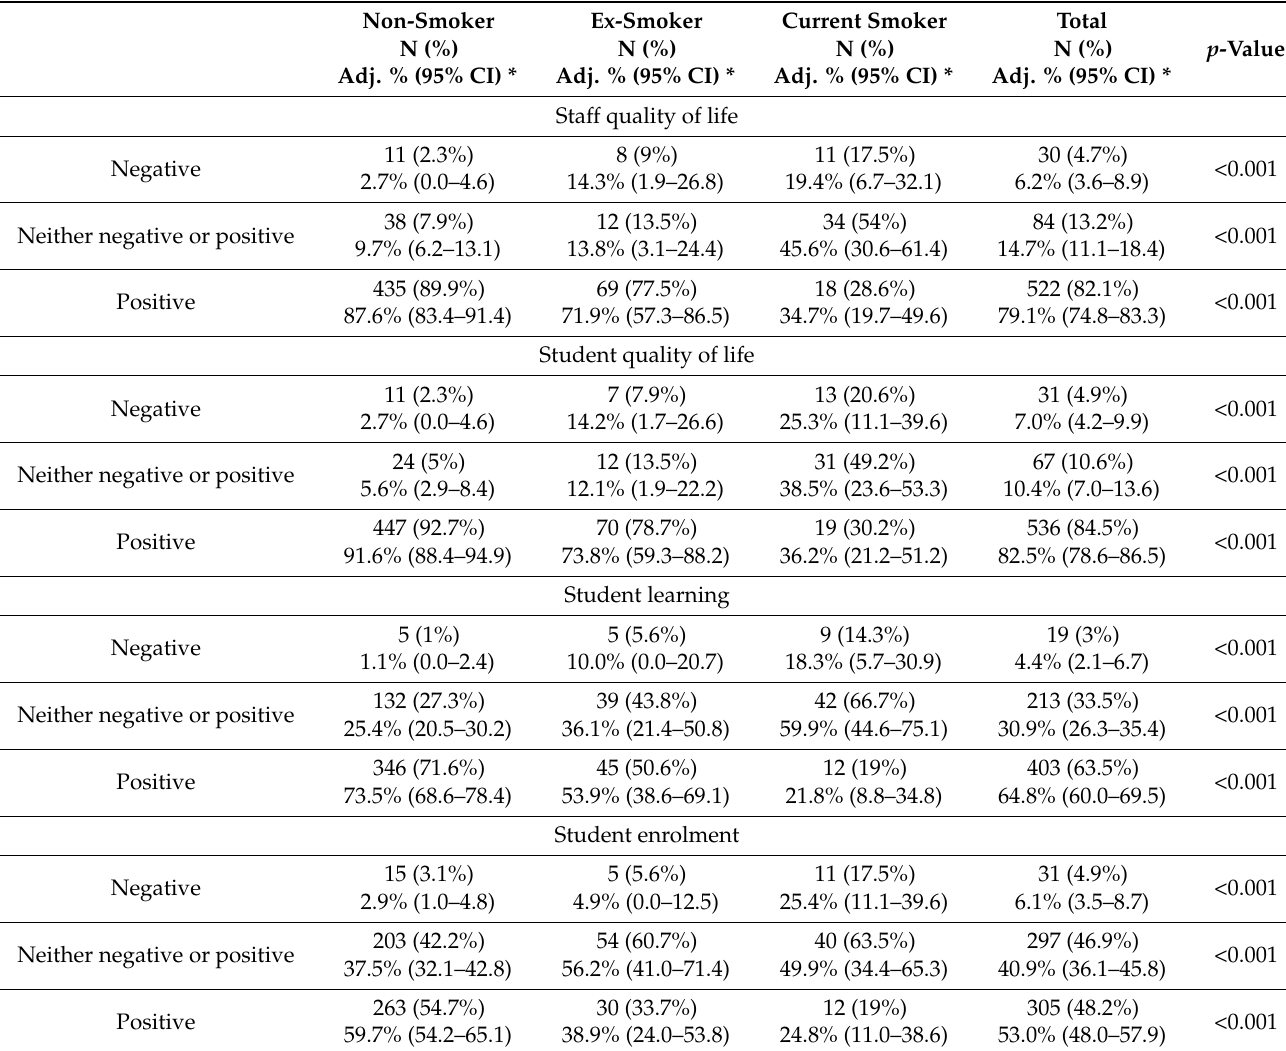
Table 4. Agreement with effects of a completely smoke-free campus policy statement reported by university staff and